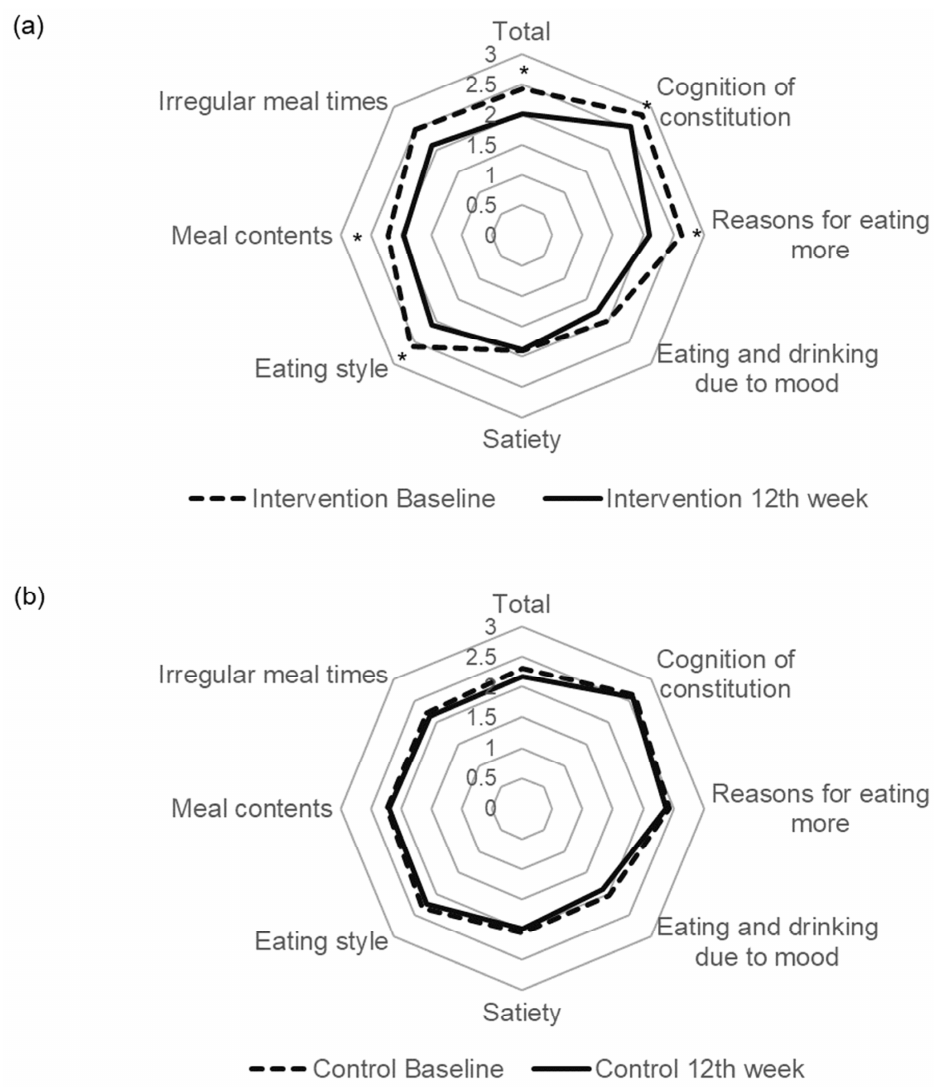
Figure 2. Changes in scores determined using the Sakata’s Eating Behaviour Questionnaire in the intervention and control groups. * p < 0.05 for each interaction between time and groups in repeated measures mixed models. ( a ) Intervention group. ( b ) Control group. The means and changes determined using BAS-2 are summarised in Table 3. At base- line, the BAS-2 total score and scores of the ten items were not significantly different be- tween the groups. However, from baseline to the 12th week, scores of ‘Right now, I feel that my body has at least some good qualities’ and ‘At this moment, I take a positive atti- tude toward my body’ increased in the intervention group and decreased in the control group ( p < 0.05, for each interaction term between time and groups in repeated measures mixed models).